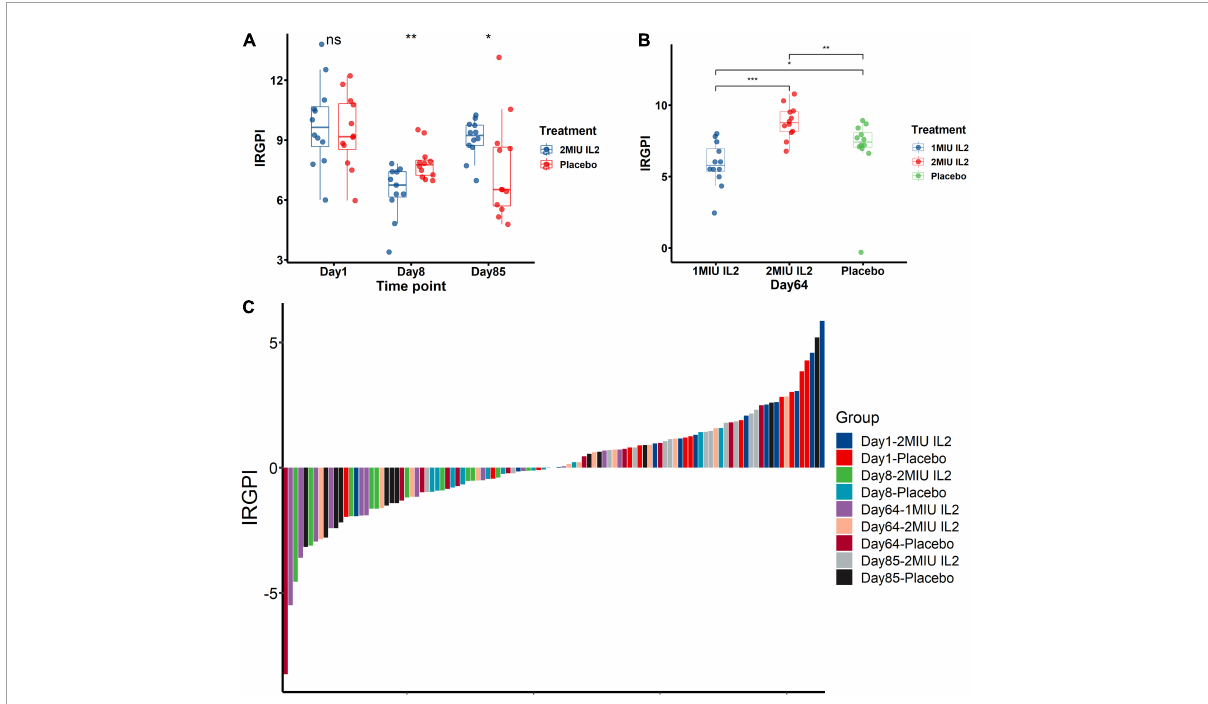
FIGURE7 The immune-related gene prognostic index (IRGPI) to therapeutic response in amyotrophic lateral sclerosis (ALS) patients and mice models. The responses and drug sensitivities of the IRGPI to immunotherapy of IL2 injection was shown in the barplots (A,B) and the waterfall plot (C) . The Wilcoxon test was used to compare the statistical differences all above. * P < 0.05; ** P < 0.01; *** P <